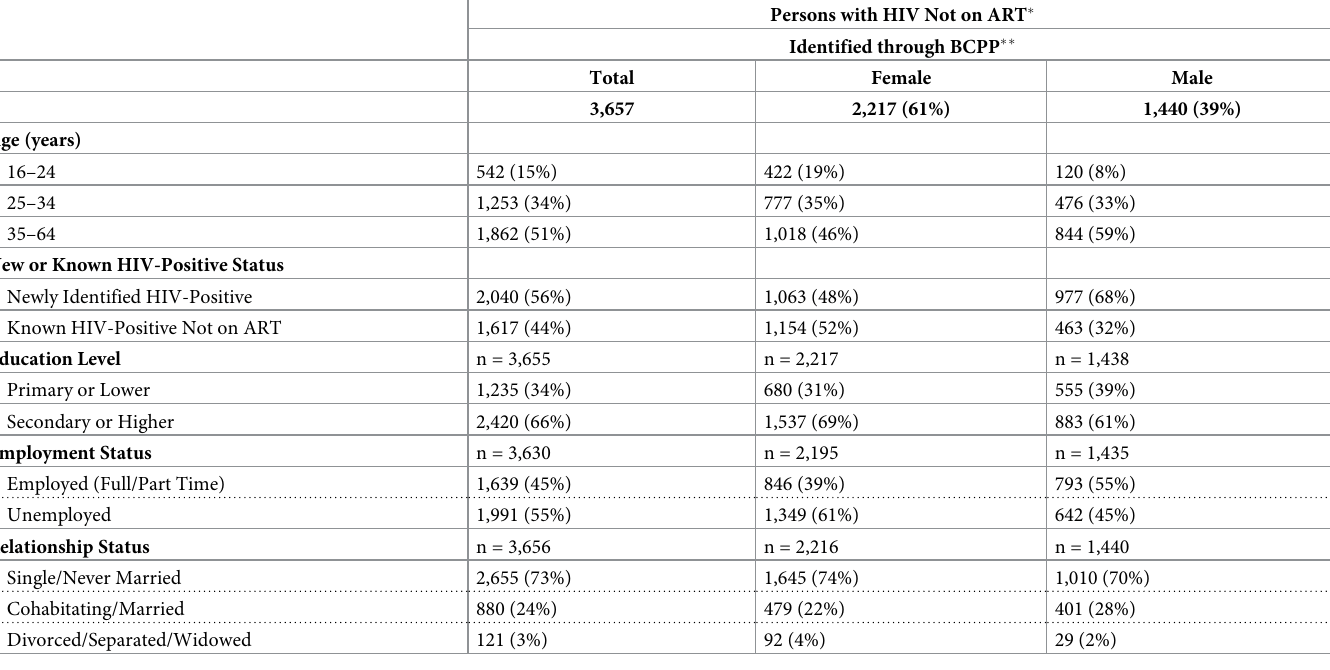
Table 1. Demographic characteristics of PLHIV referred to